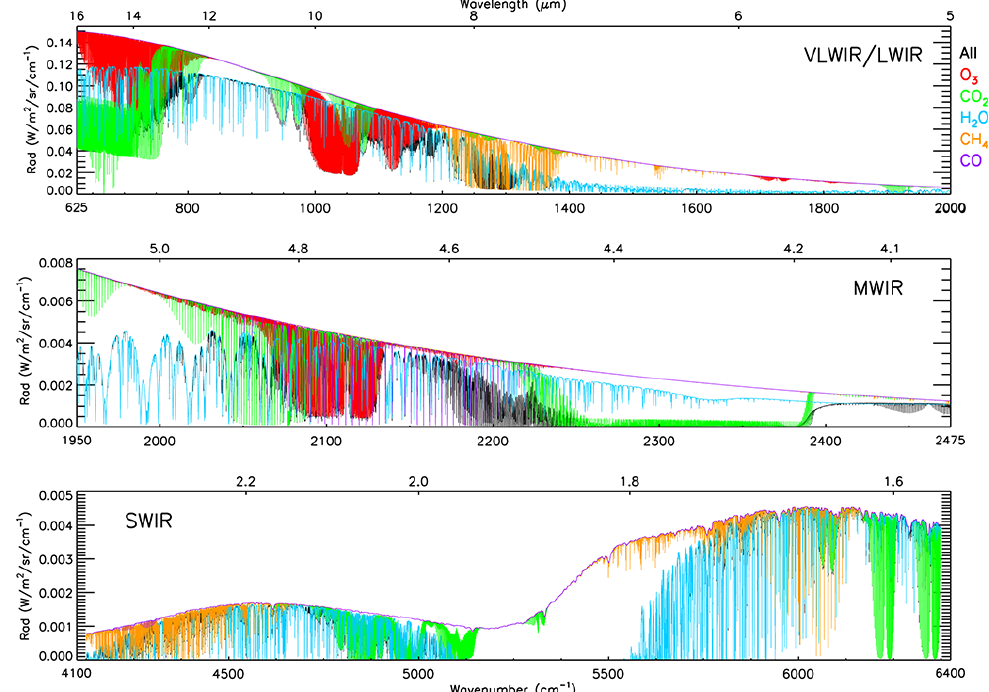
Figure 2. Simulated top-of-the-atmosphere monochromatic radiances (black) in the 650–7000cm − 1 wavelength range for an atmospheric profile near Houston. Also shown are radiances corresponding to (red) O 3 , (green) CO 2 , (blue) H 2 O, (orange) CH 4 , and (purple) CO